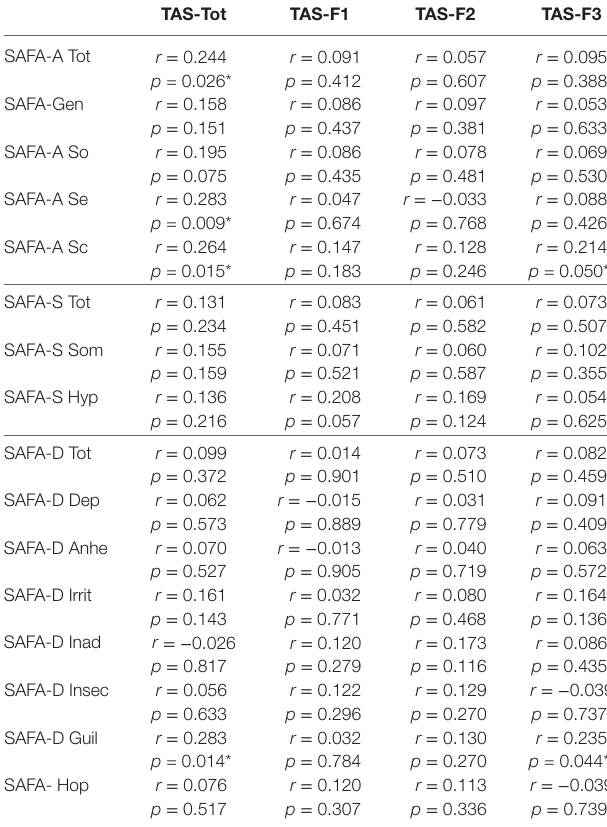
children frequency/intensity based